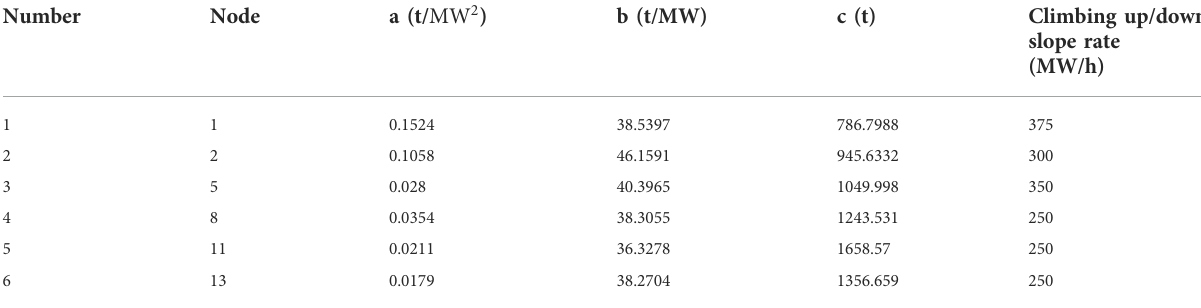
TABLE 2 IEEE-30 node system thermal power unit parameters.